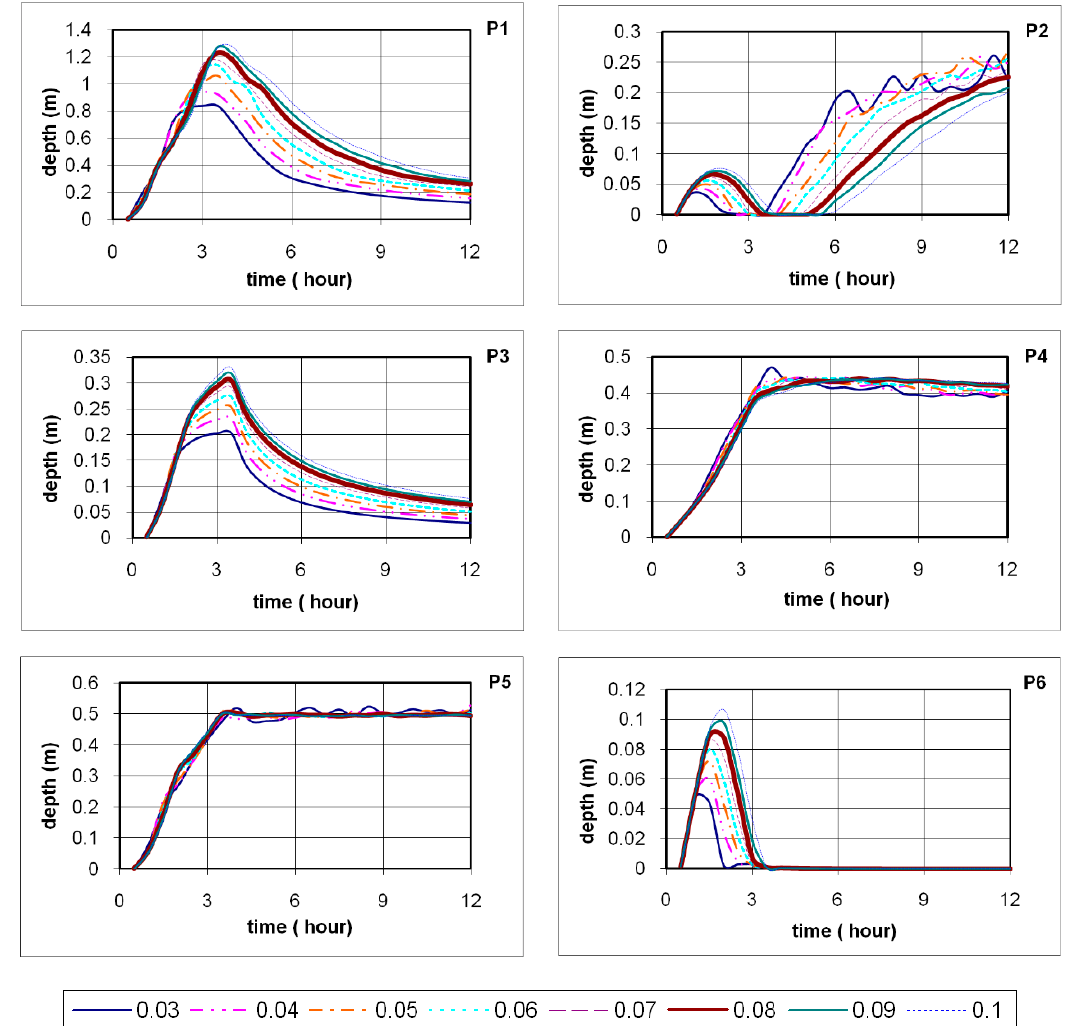
Figure 10. E ff ects of di ff erent Manning coe ffi cients on flood depths for the pixels Figure 10. Effects of different Manning coefficients on flood depths for the pixels P1–P6.